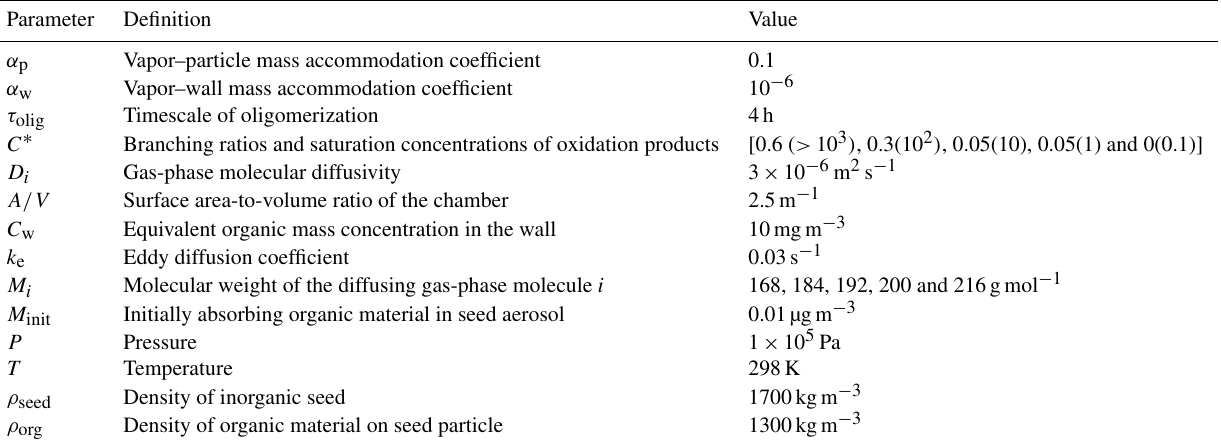
Table 2. Coupled vapor–particle dynamics model